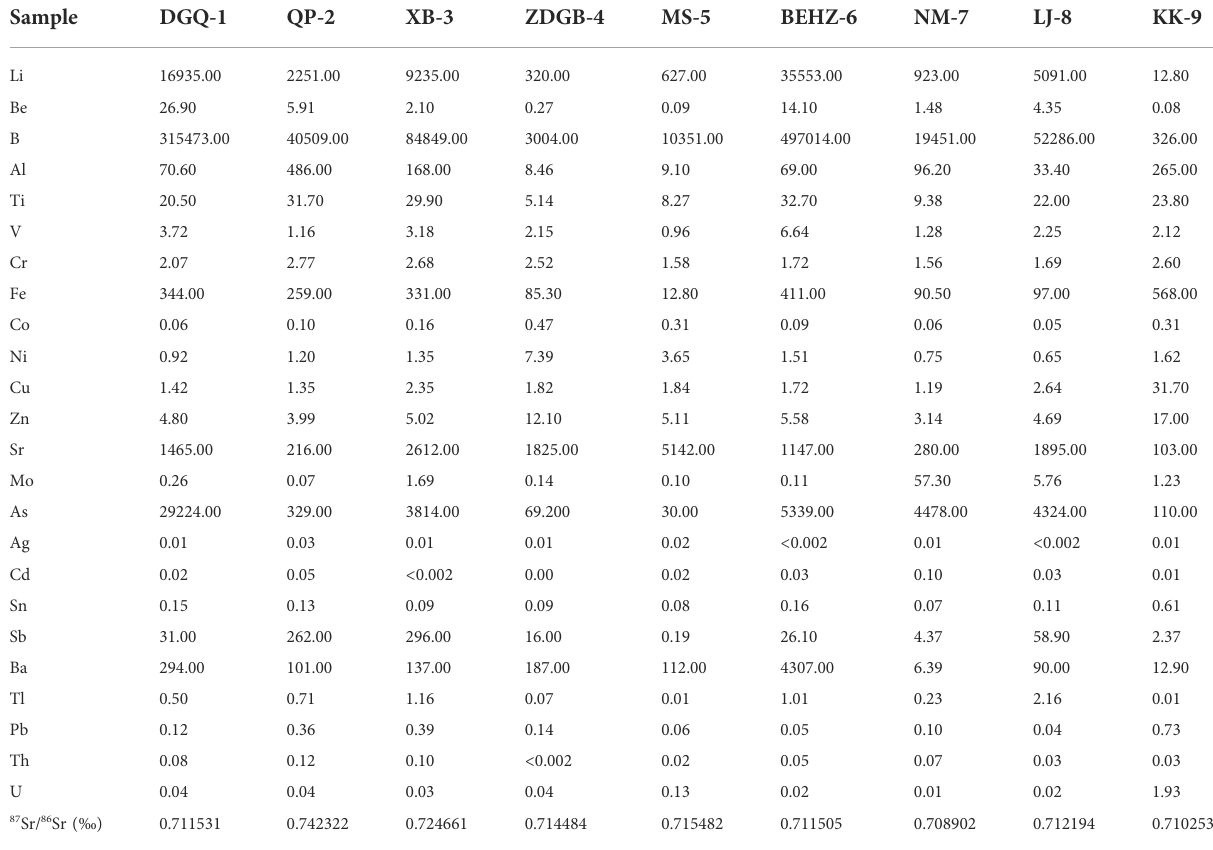
TABLE 2 Chemical composition of trace elements of the spring waters along the Karakorum Fault. The values were expressed in μ